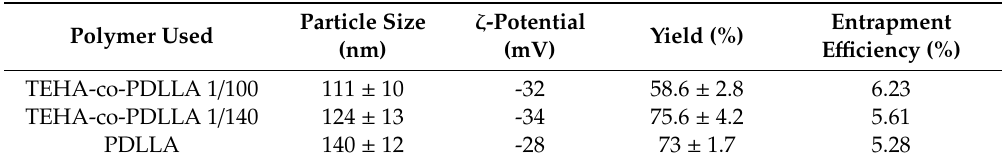
Table 2. Particle size distribution, yield, and % EE of magnetic core–shell drug-loaded polymeric